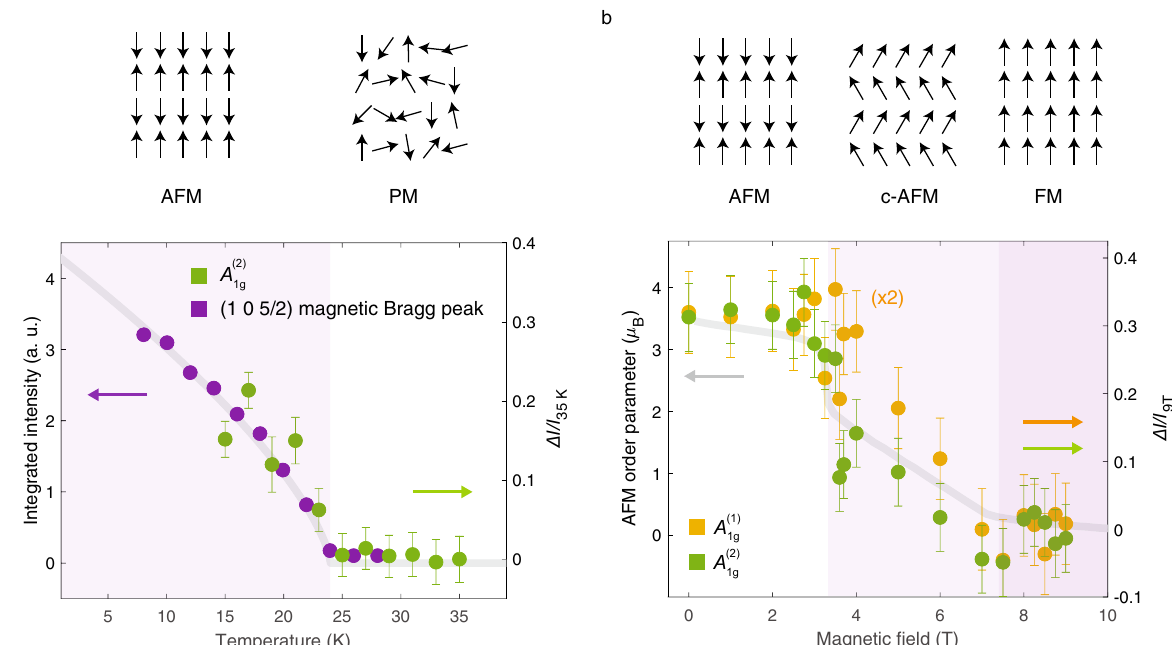
Fig. 2 Phonon intensities track the antiferromagnetic order parameter. a Temperature-dependent fractional change in integrated intensity, Δ I = I 35K , of the A 1 g (2) mode, overlayed on integrated intensity of the (1 0 5/2) neutron diffraction peak from reference 14 . The gray line is a fi t to A 1 (cid:2) T = T N β = 0.35, T = 24 K. b The fi eld-dependent fractional change in integrated intensity, Δ I = I N parameter, given by M (cid:2) 4 : 5 µ B , where M is the magnetization measured by magnetometry from reference 15 . Error bars are standard deviations in fi t